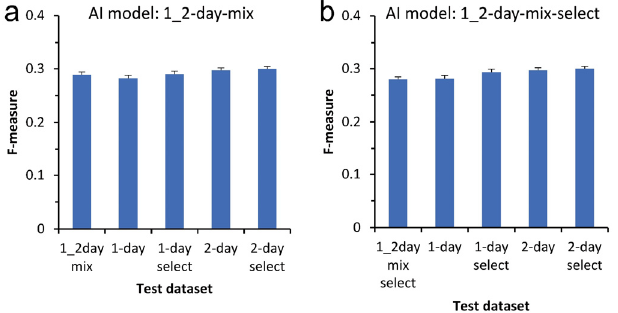
Figure 4. Effect of combining datasets for training AI. ( a ) AI model trained using a mixture of 1- and 2-day culture images datasets including 1000 image pairs. ( b ) AI model trained using the mixture of 1- and 2-day culture images dataset including 1000 pairs without blank images. Mean ± S.E.M., n = 1000.